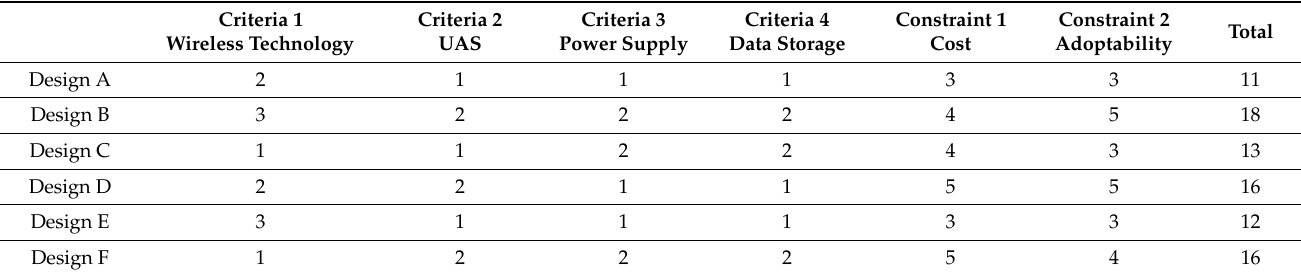
Table 1. The unmanned aerial systems (UAS) data ferry decision matrix table for six proposed designs based on the four criteria and two constraints with the total points for each